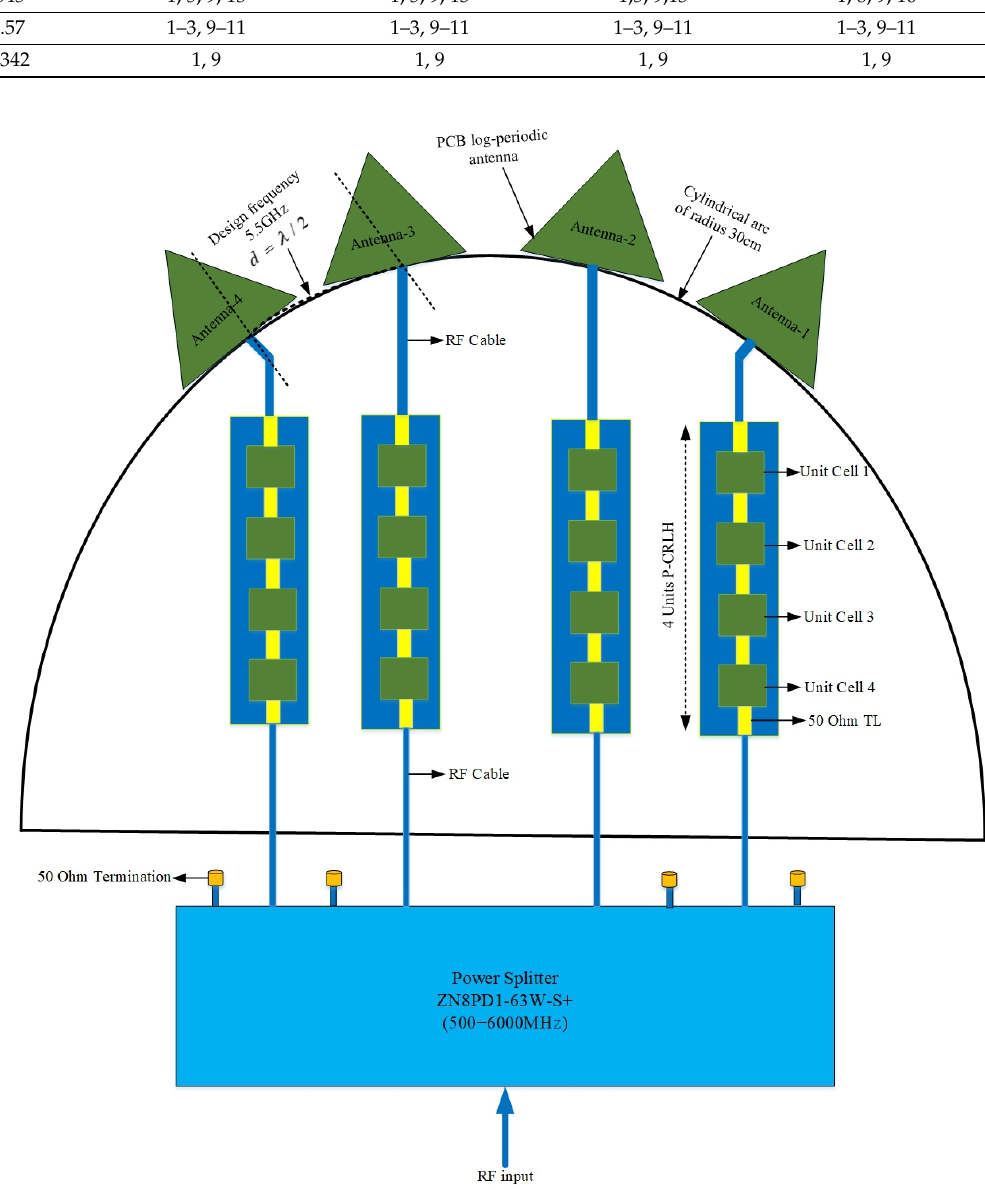
Figure 5. Schematic of the 1 × 4 P-CRLH excited cylindrical phased array. Table 1. Phases (degrees) for broadside, 15, ° and 30 ° main-beam scanning of a cylinder with 𝑟 = 30 cm.